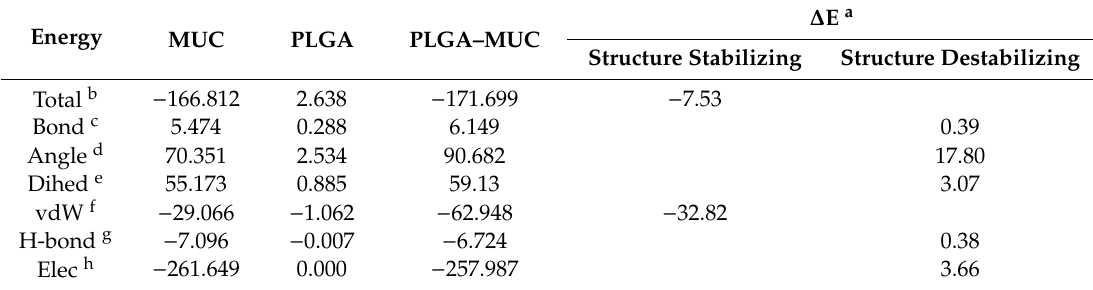
Table 2. Inherent energy attributes of poly (D, L-lactic-co-glycolic acid)–mucin (PLGA–MUC) conjugate calculated using static lattice atomistic simulations in vacuum.